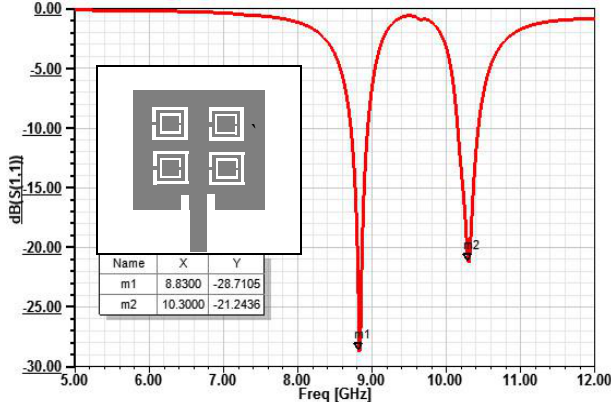
Figure 8: Dual-band antenna with four CSRR cells and its simulated return loss.